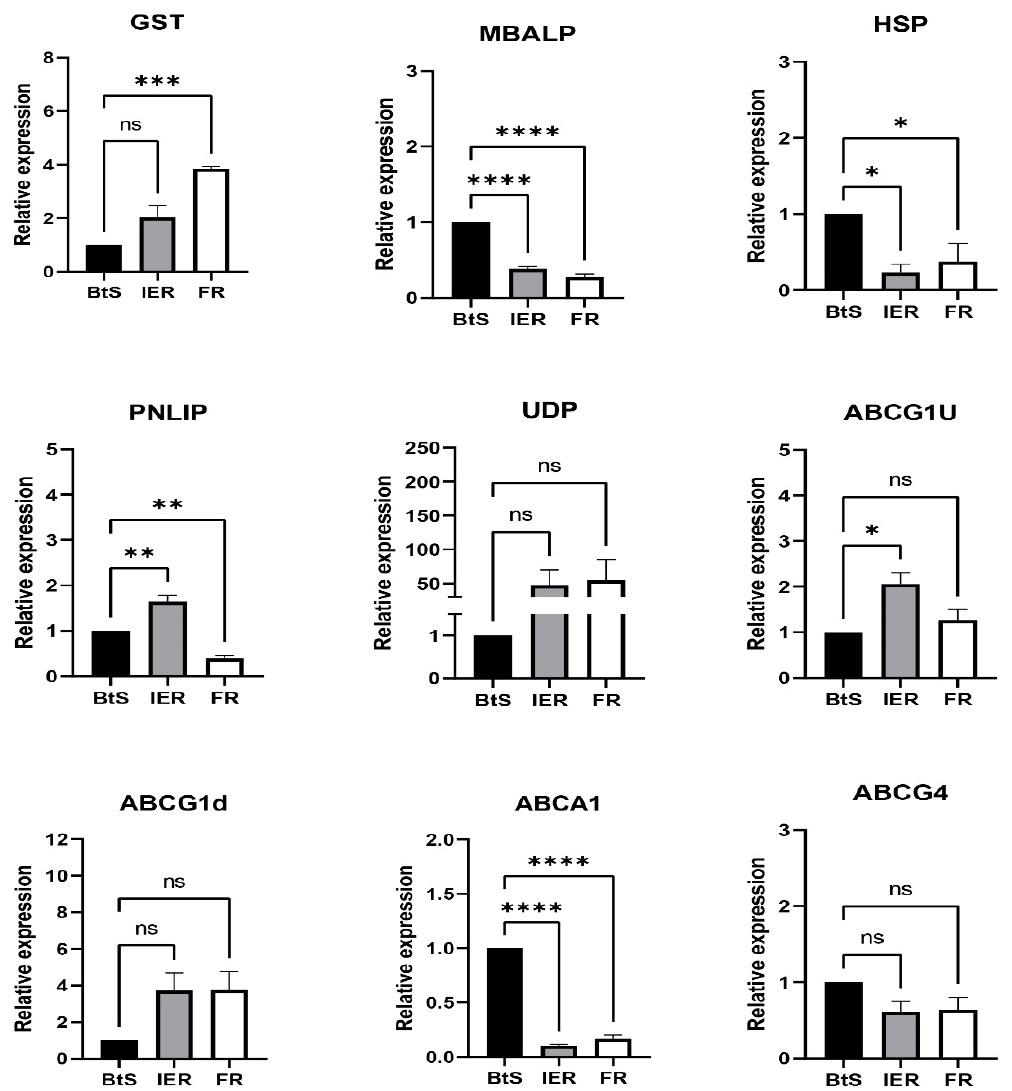
Figure 4. RT-qPCR results of differentially expressed genes. Three biological replicates of each strain of ACB-BtS, ACB-FR and ACB-IeR were performed in three technical replicates. The height of the bar graph represents the average of 2 −∆∆ CT values. The significance threshold is set to p ≤ 0.05, “ns” indicates that the difference is not significant, “*” indicates the difference is significant, and the number of “*” indicates the degree of significance.